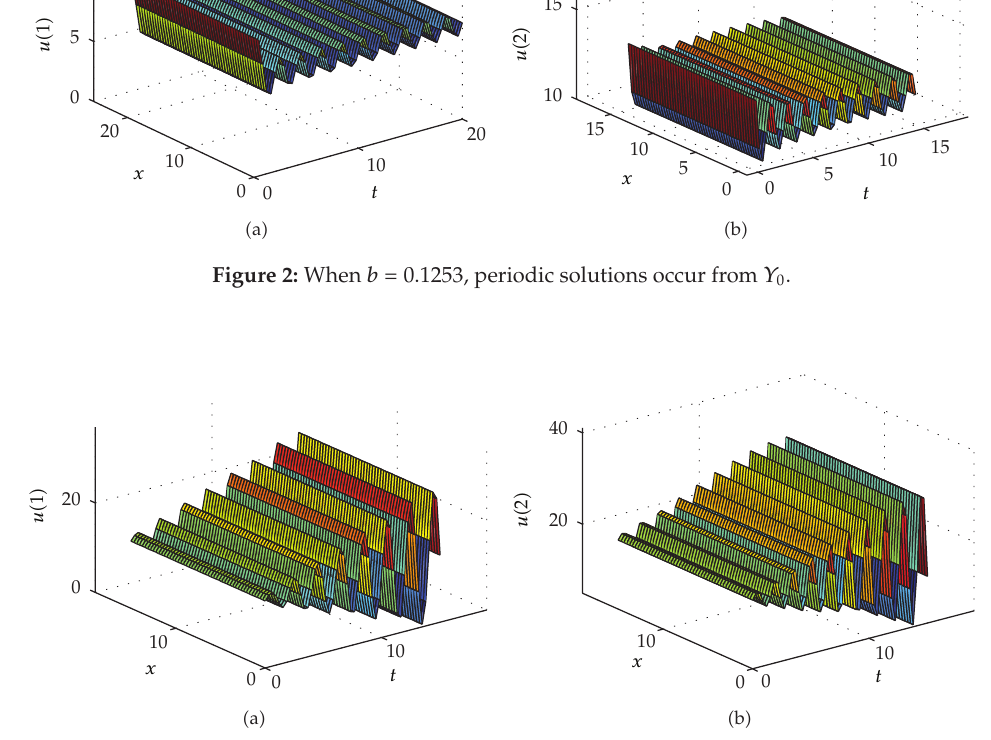
Figure 3: When b (cid:5) 1 . 3, the positive equilibrium point Y 0 is